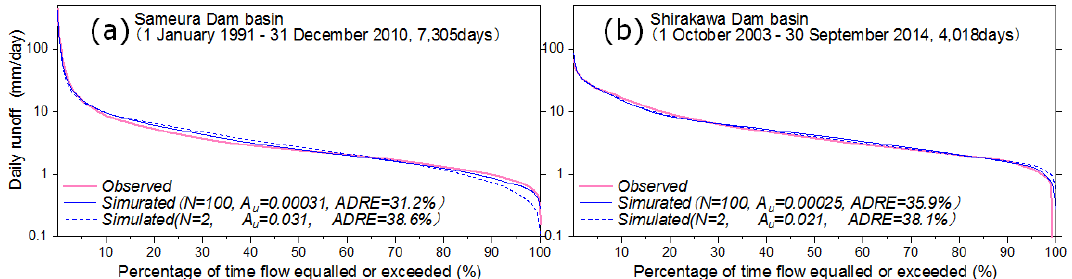
Figure 5. Examples of the observed and simulated flow duration curves for the Sameura Dam basin (a) and the Shirakawa Dam basin (b)